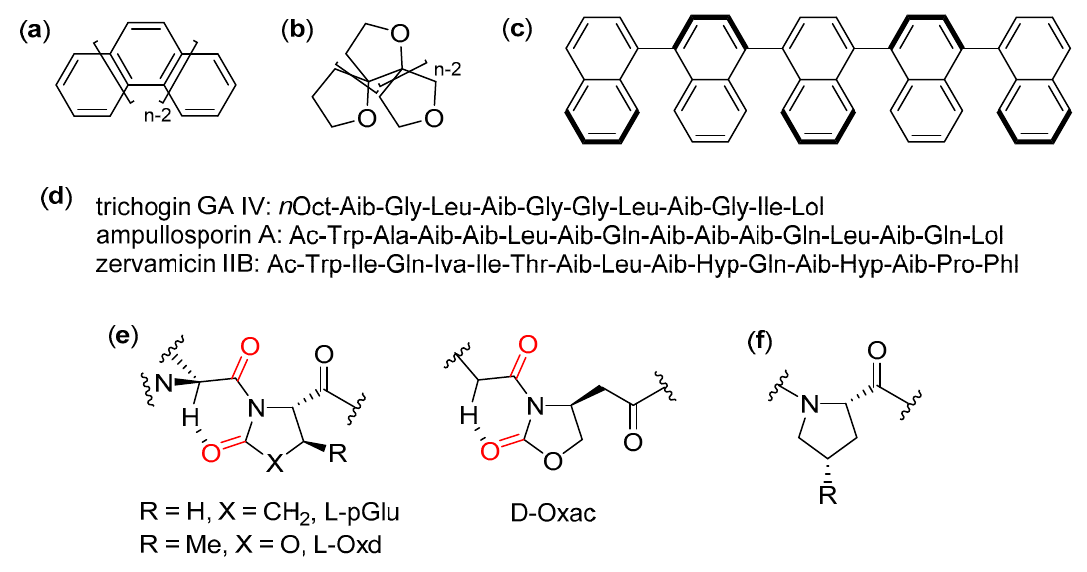
Figure 3. General structures of ( a ) [ n ] helicenes (Ref. [31]), ( b ) polyoxapolyspiroalkanones (Ref. [32])